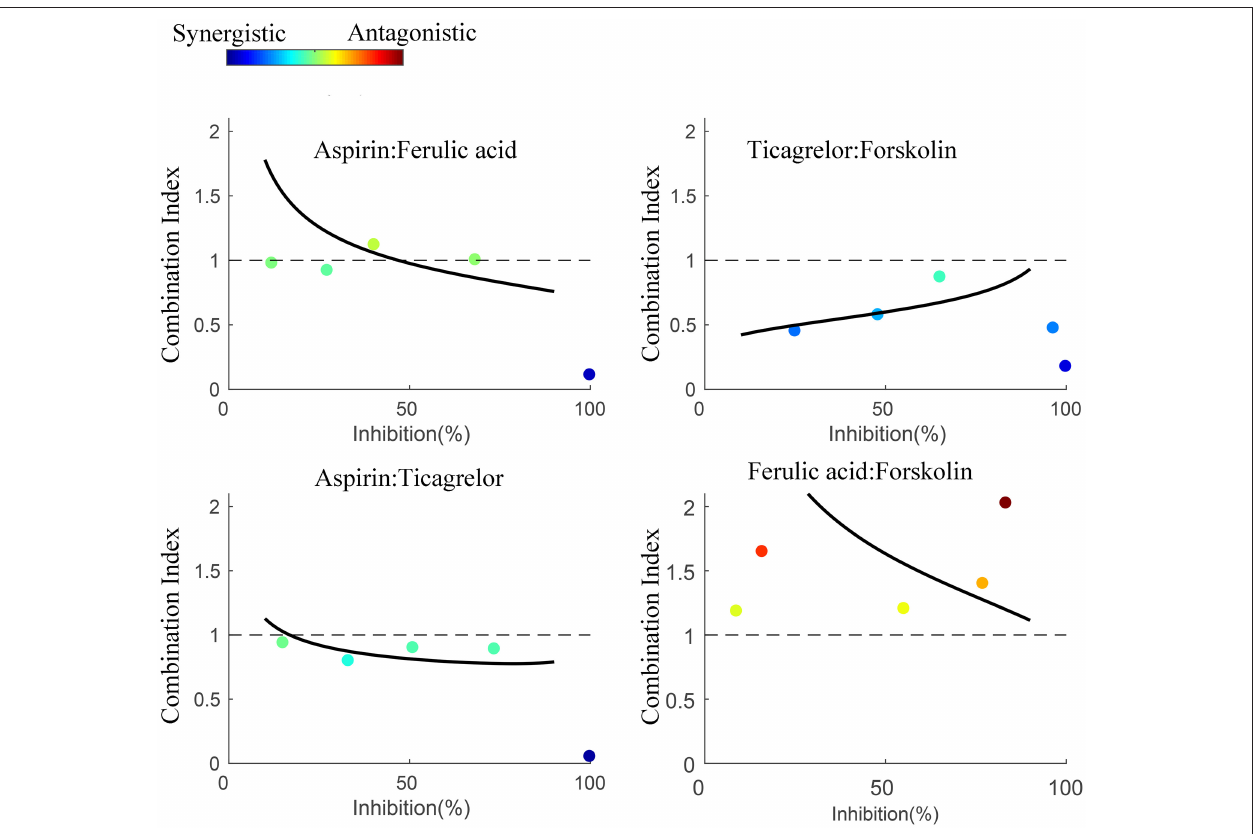
FIGURE 6 | CI-Fa plot for the constant ratio experiment. The dots in the figure are the data points in the drug pair experiment with different concentrations. Combination Index value was calculated for each drug pairs as indicated by the color of the dots, red for antagonism and blue for synergistic. The results confirmed synergism between T:MH (ticagrelor:forskolin) and A:T (aspirin:ticagrelor), and antagonism between DG:MH (ferulic acid:forskolin) as predicted in generation 2. The interaction between A:DG (aspirin:ferulic acid) was found to be mainly additive